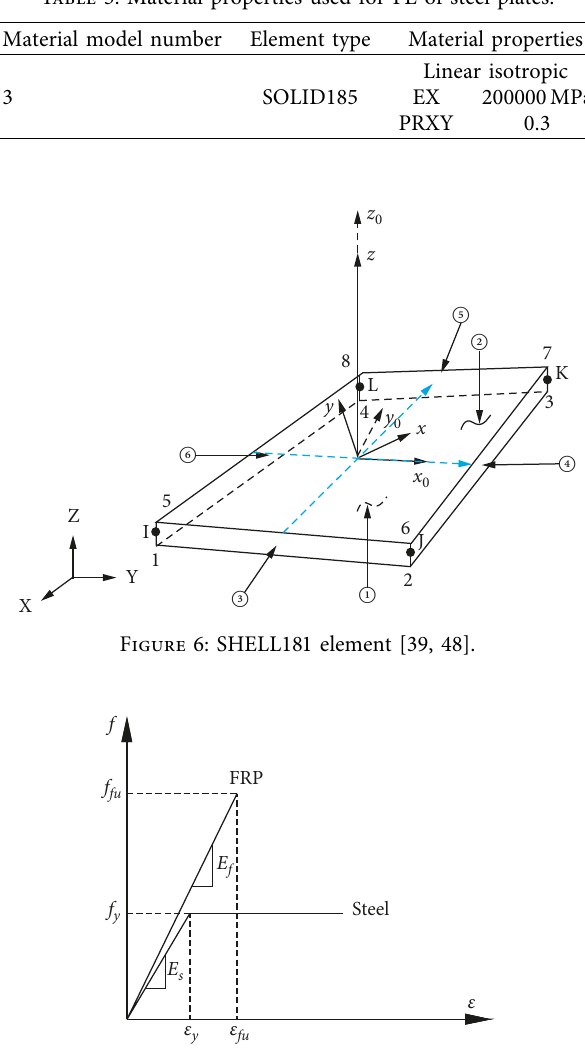
Figure 7: Stress-strain relationships for steel reinforcement and FRP composite